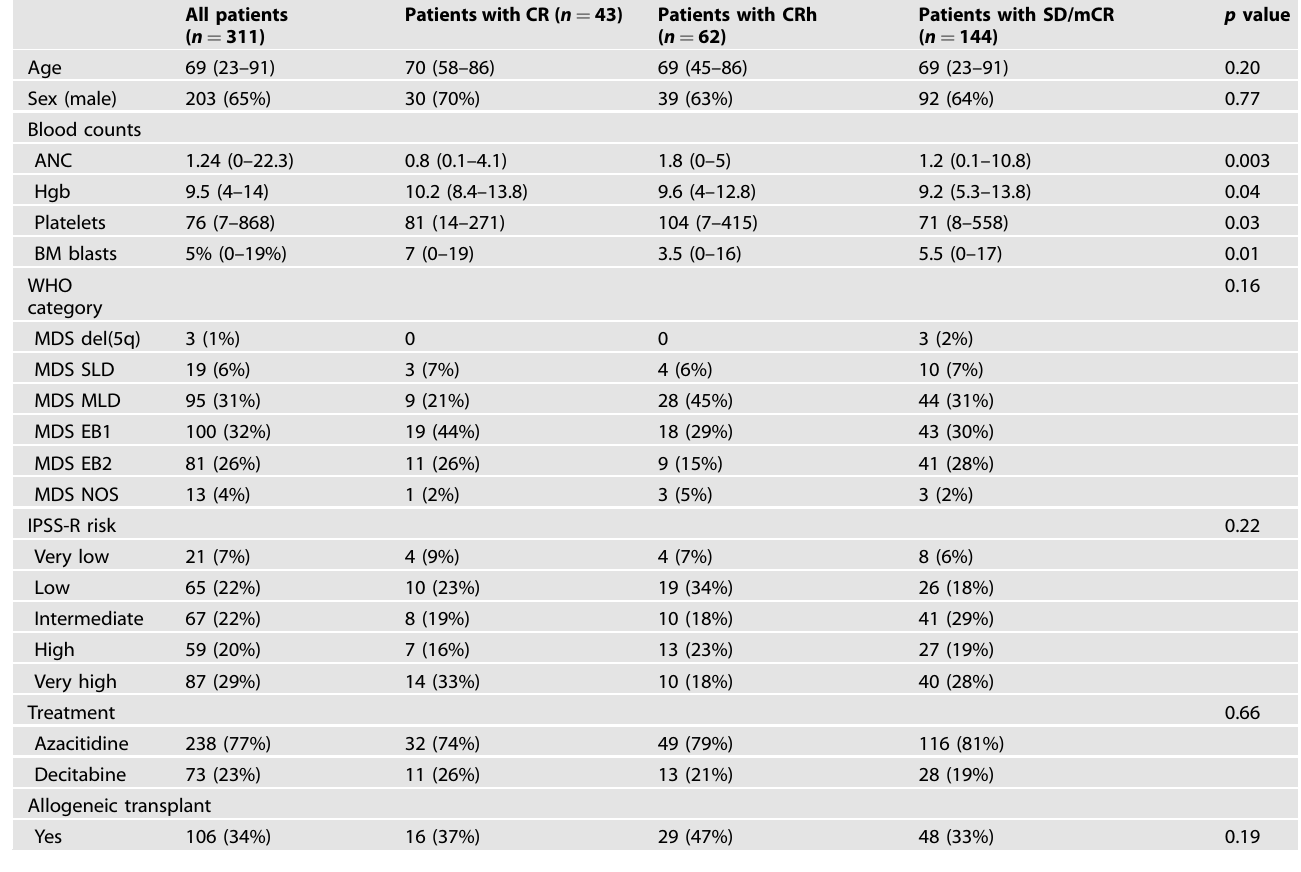
Table 1. Patient characteristics.